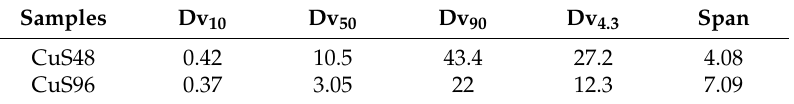
Table 4. Particles size distribution (microns) in samples CuS48 and CuS96.